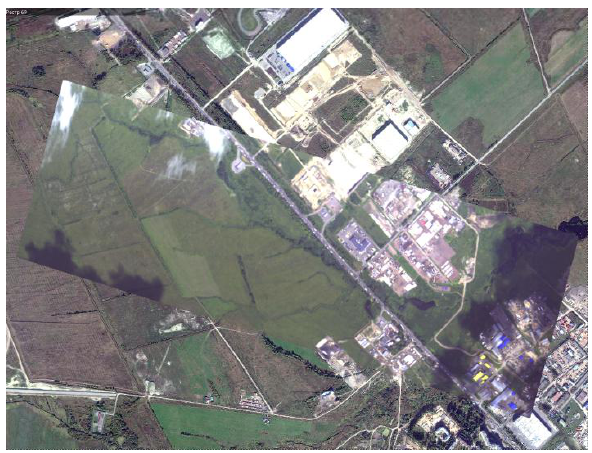
Image 7. A test image from the second series corrected with polynomial